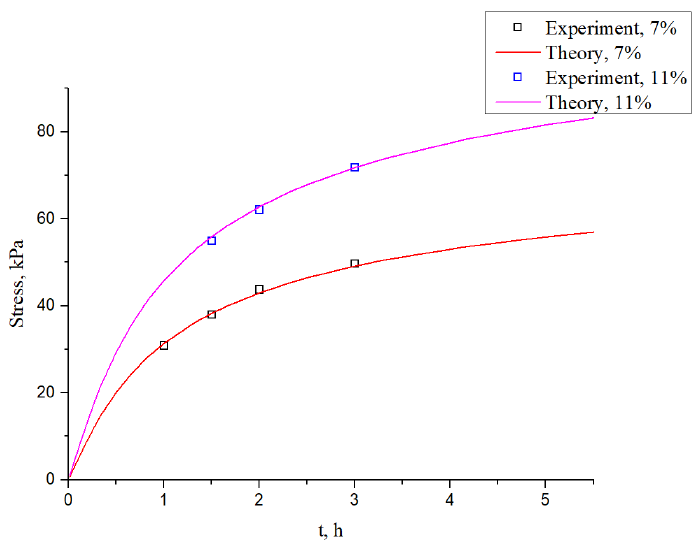
Figure 13. Schematics of the relationship between interface stress and bonding time in theoretical calculation and experiments. Table 1. Model parameters used in this paper.